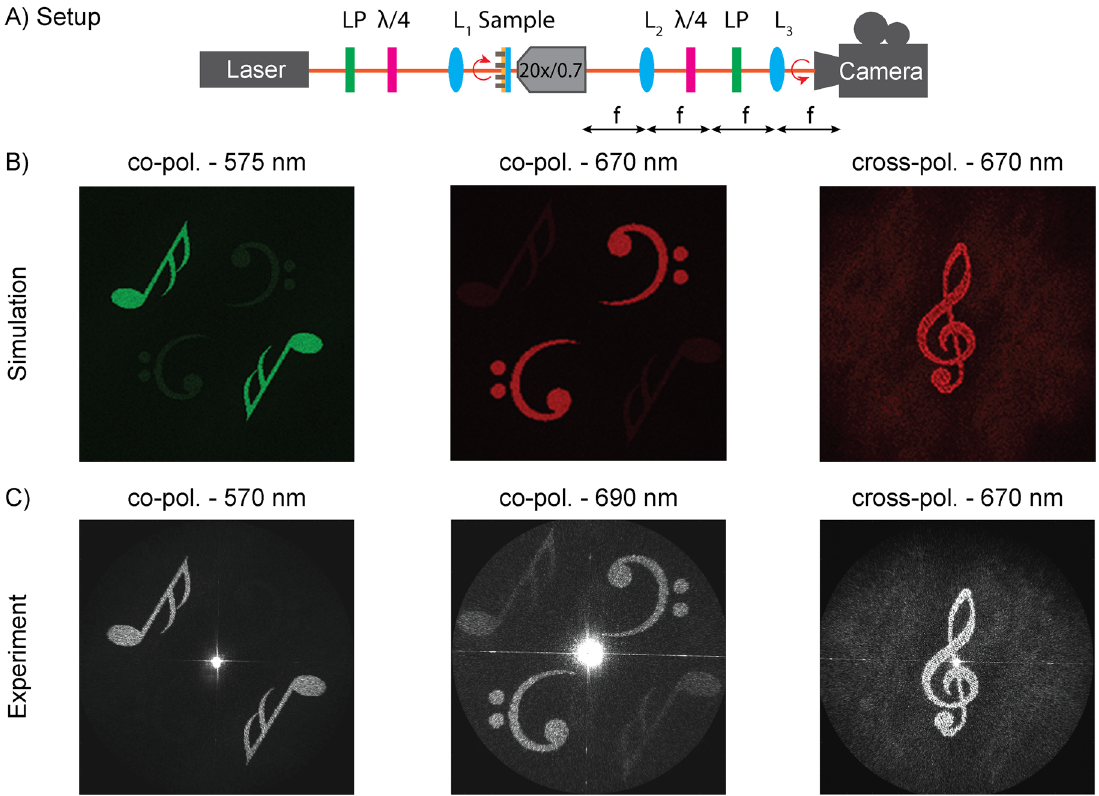
Figure 5: Measured holograms and their target images. (A) The sample is illuminated with laser light. The wavelength can be tuned and each set wavelength has a bandwidth of 5 nm. The input polarization state is circular, while the output state can be changed from the co-to the cross-circular polarization state. The encoded Fourier- holograms are imaged to the monochrome camera using a 4 f -setup. (B) Simulated holograms. The music notes and bass clefs are the dominant target image at 575 nm and 670 nm in the circular copolarization state. In the cross-polarization state, at 670 nm, the violin clef appears based on the Pancharatnam – Berry phase. (C) Experimentally measured holograms.